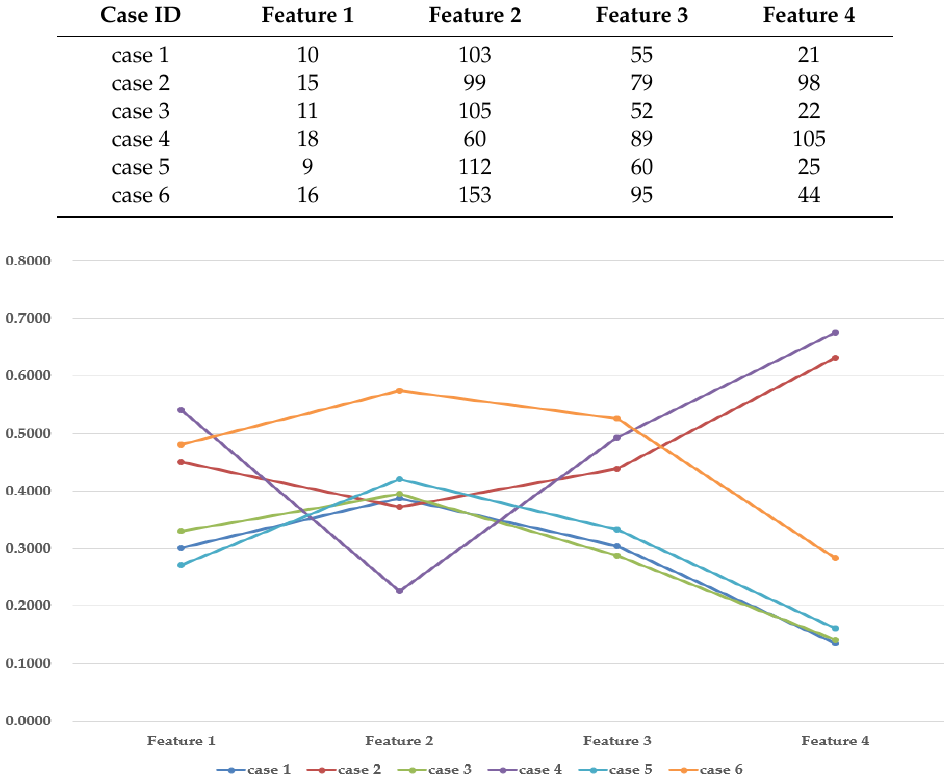
Figure 1. Visualization of cases from Table 2.